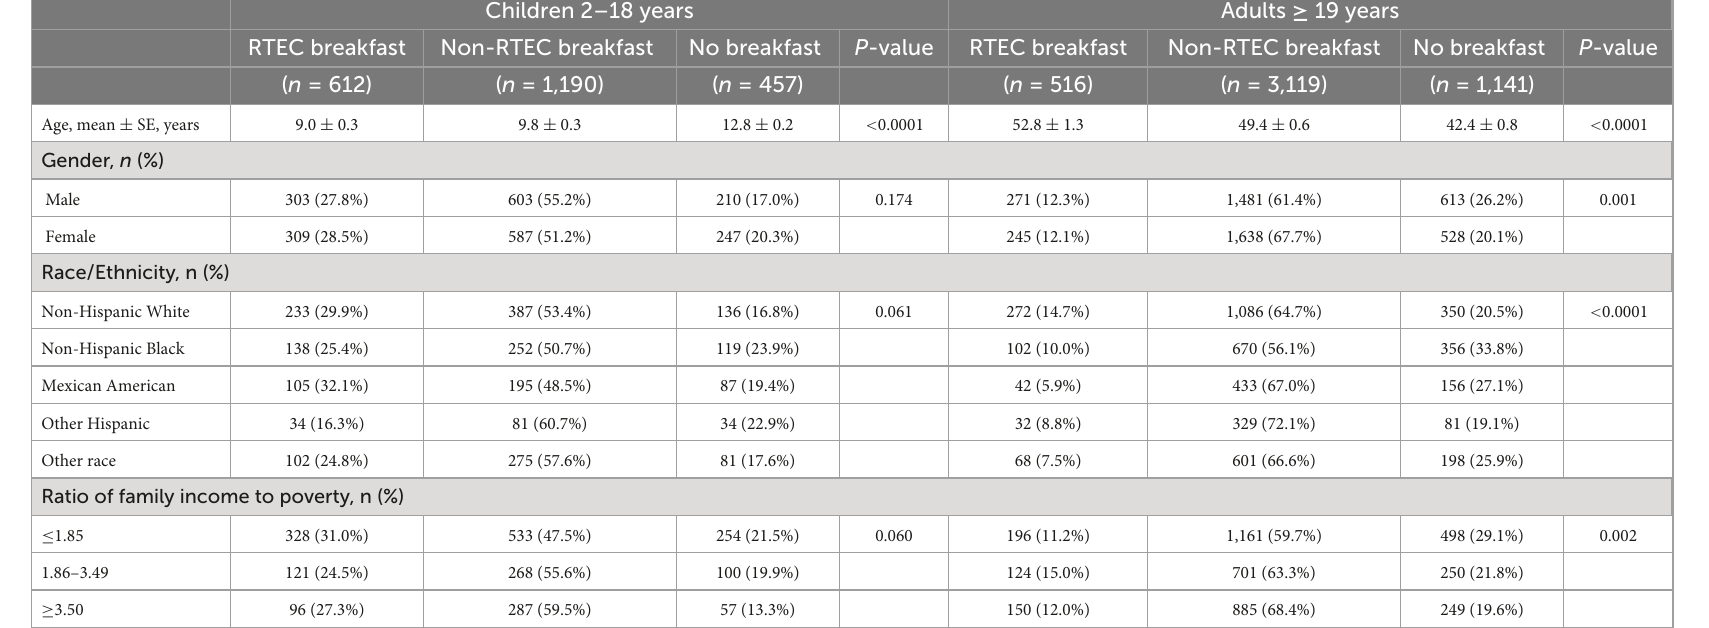
TABLE 1 Demographic characteristics of US children and adults by breakfast status, National Health and Nutrition Examination Survey,